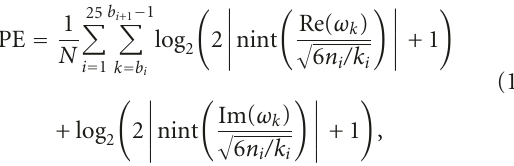
Figure 1: 3 Layers of auditory sound source